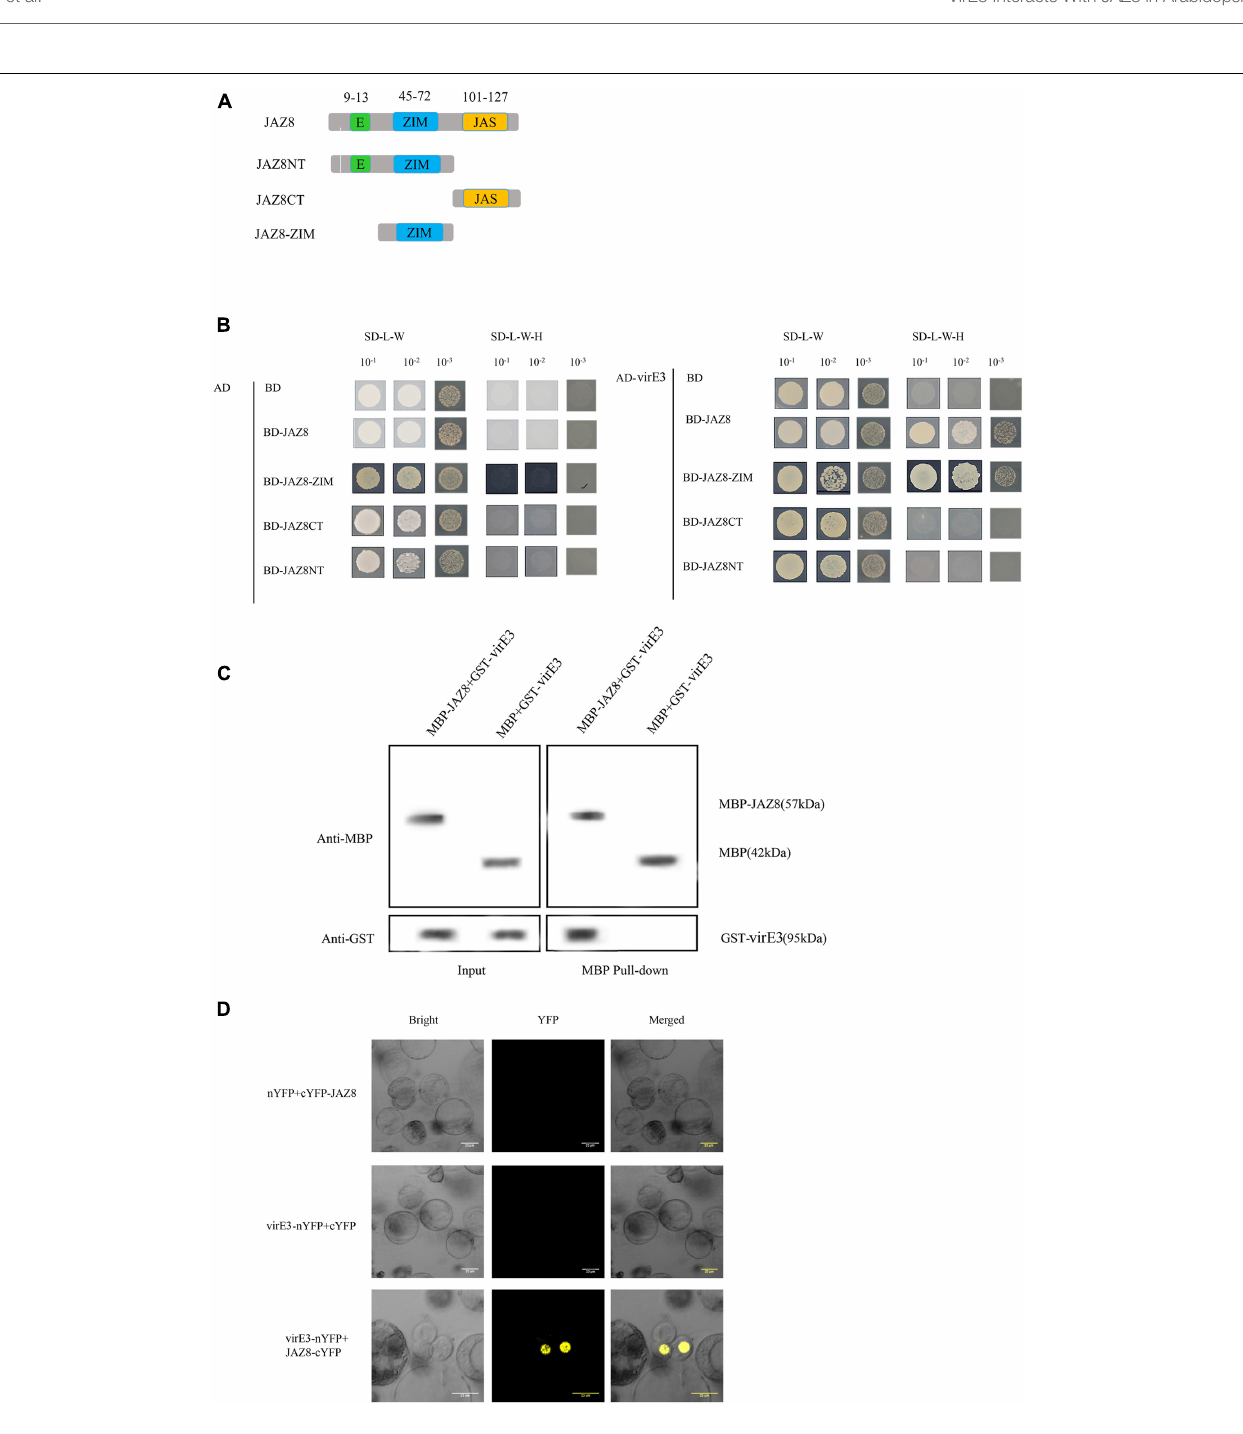
Frontiers in Plant Science |